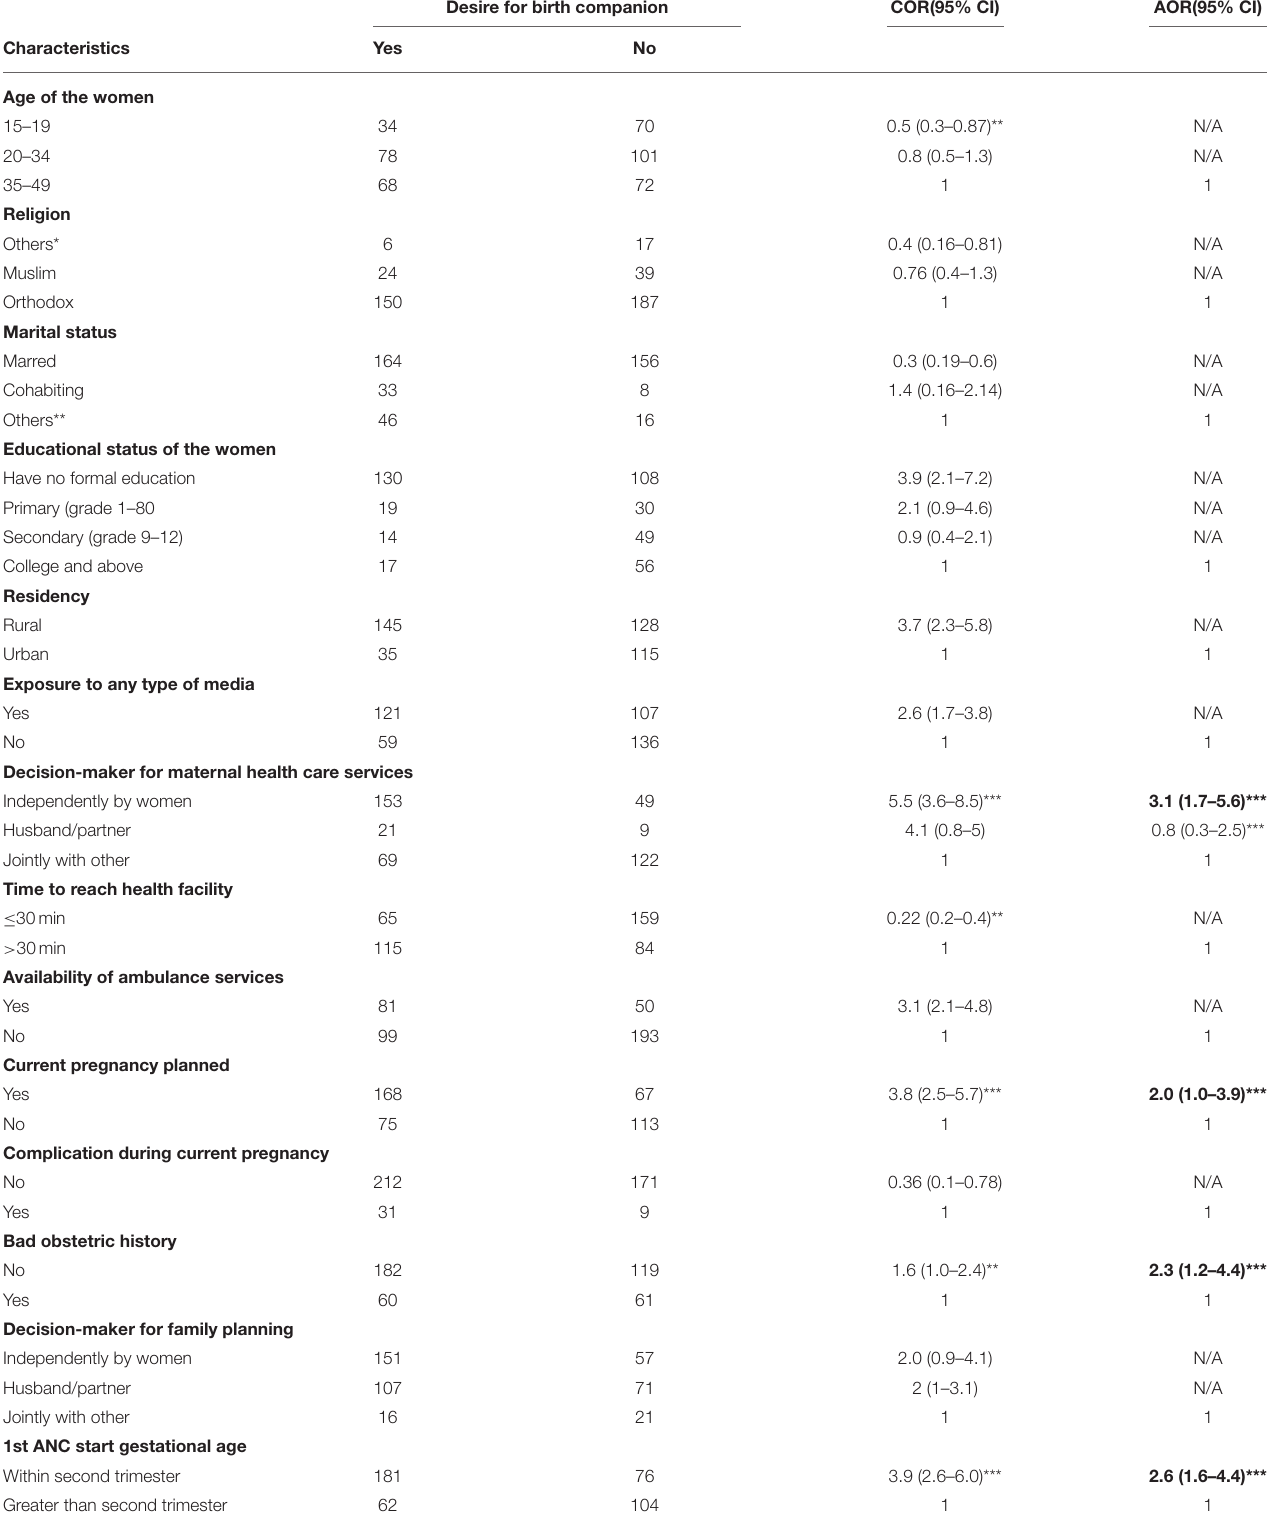
TABLE 5 | Factors associated with women’s desire for birth companionship in Debremarkos city, northwest